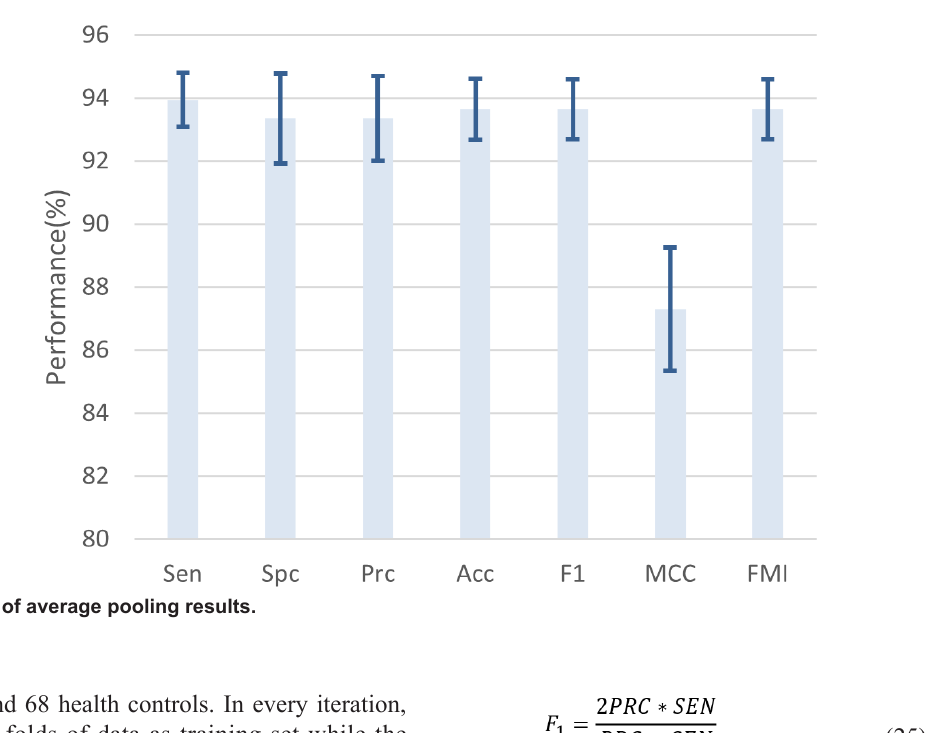
sclerosis slices and 68 health controls. In every iteration, we adopted nine folds of data as training set while the other one fold as testing set and repeated this procedure ten times. Figure 5 described this process of splitting the dataset into ten folds and repeating training-testing for ten